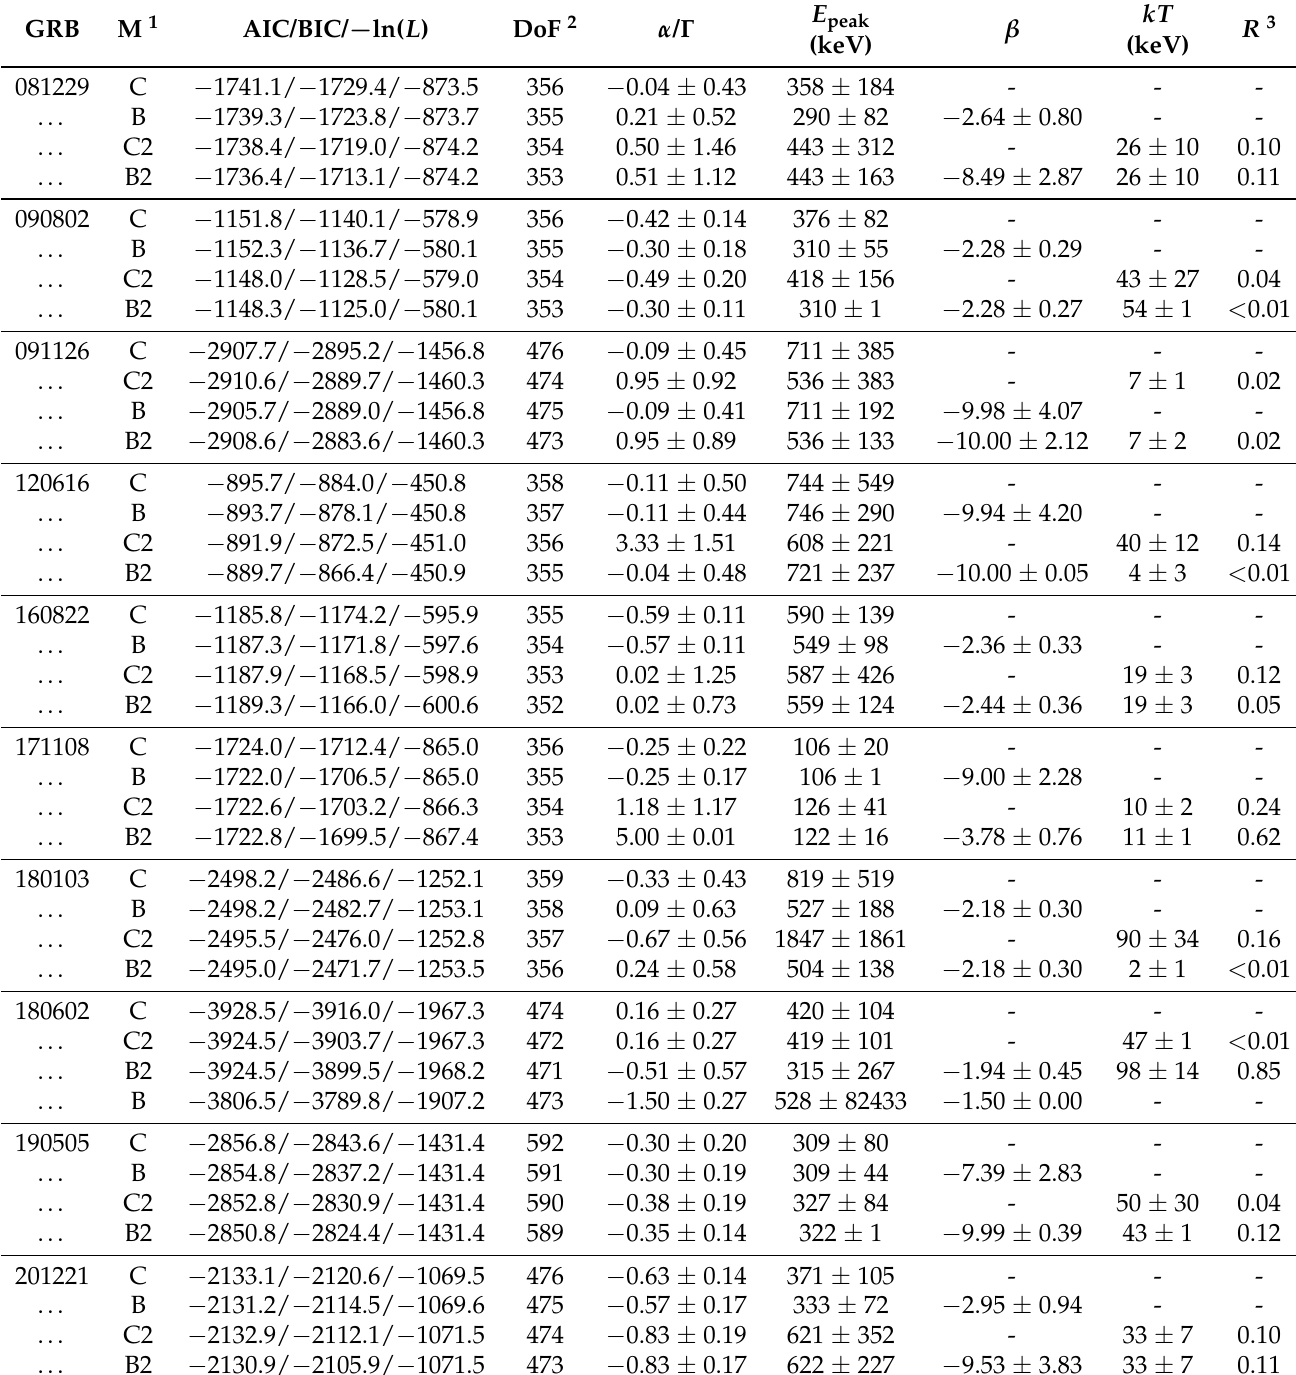
Table 2. Derived spectral parameters of four spectral models for each GRB in our